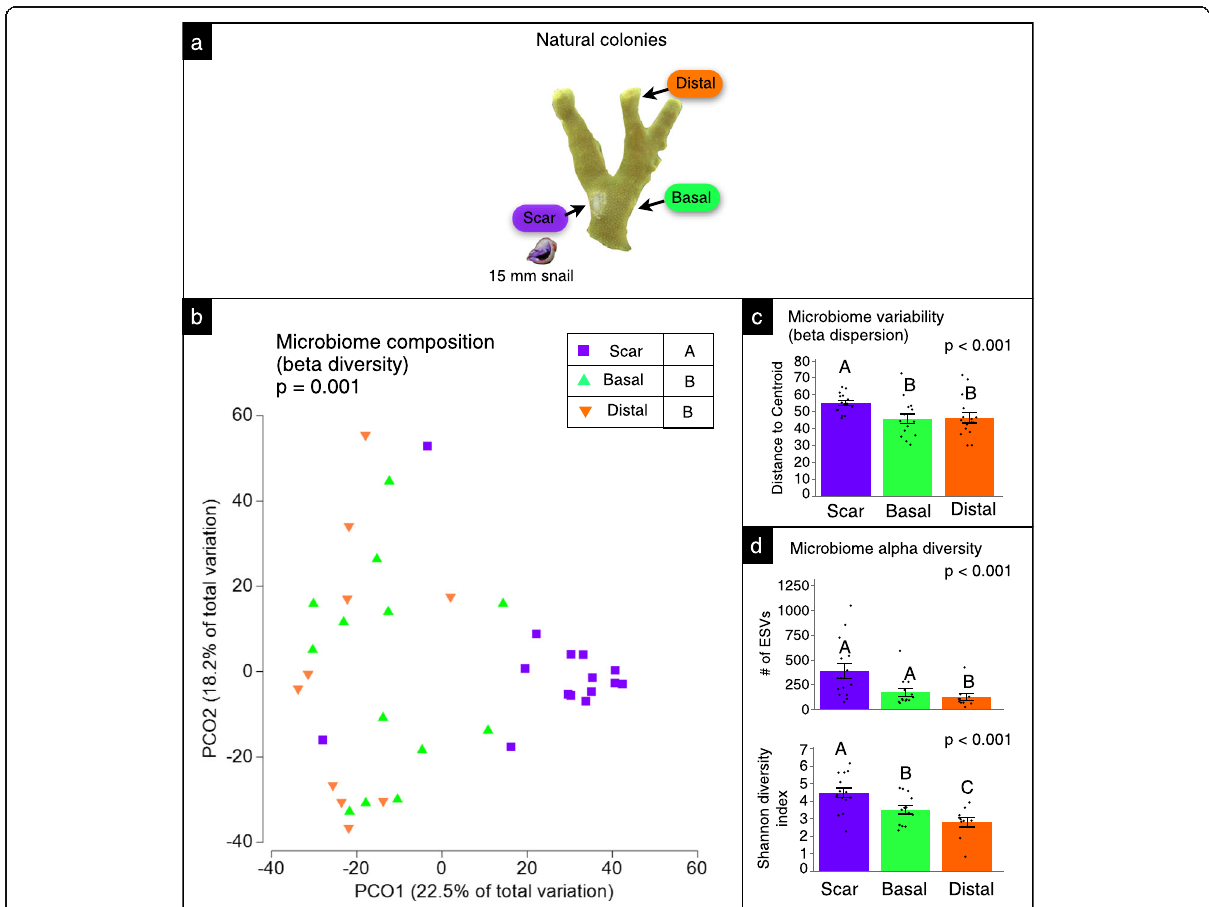
Fig. 4 Microbiomes of scar, basal, & distal locations on natural colonies with snail feeding. a Sampling schematic of locations from natural coral colonies that were subjected to snail feeding used for analyses (one-factor test, factor: treatment). b Microbiome composition (beta diversity) of samples by location. Letters in legend denote significant differences ( p < 0.01). c Microbiome variability (beta dispersion) of samples by location. d Microbiome alpha diversity of samples by location. Letters in legend denote significant differences ( p < 0.01). Analyses were performed following rarefaction (subsampling without replacement) to a uniform sequence count of 8013 sequences per